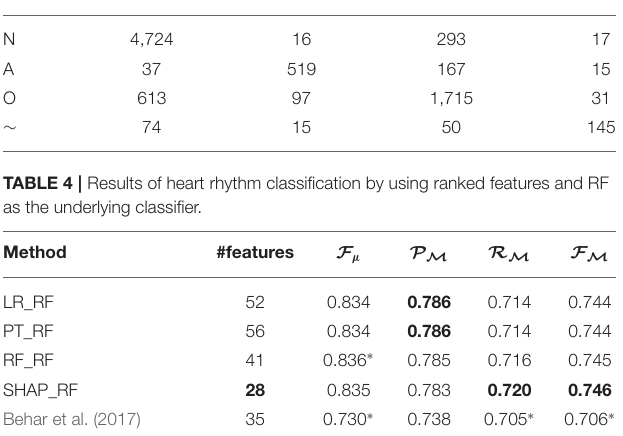
TABLE 3 | Average confusion matrix obtained from feature importance by SHAP and RF classification based on 10-fold cross-validation. n a